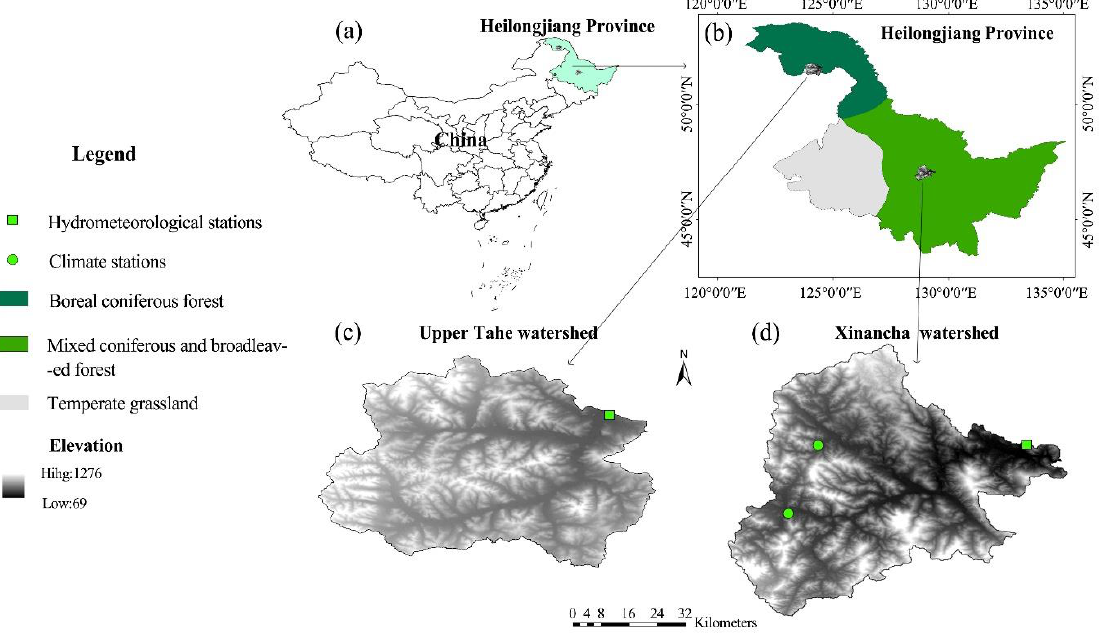
Figure 1. Locations ( a ); forest types ( b ); topography of the UTH watershed ( c ); and topography of the XNC watershed ( d ). Table 1. Watershed characteristics for the UTH watershed and XNC watershed.